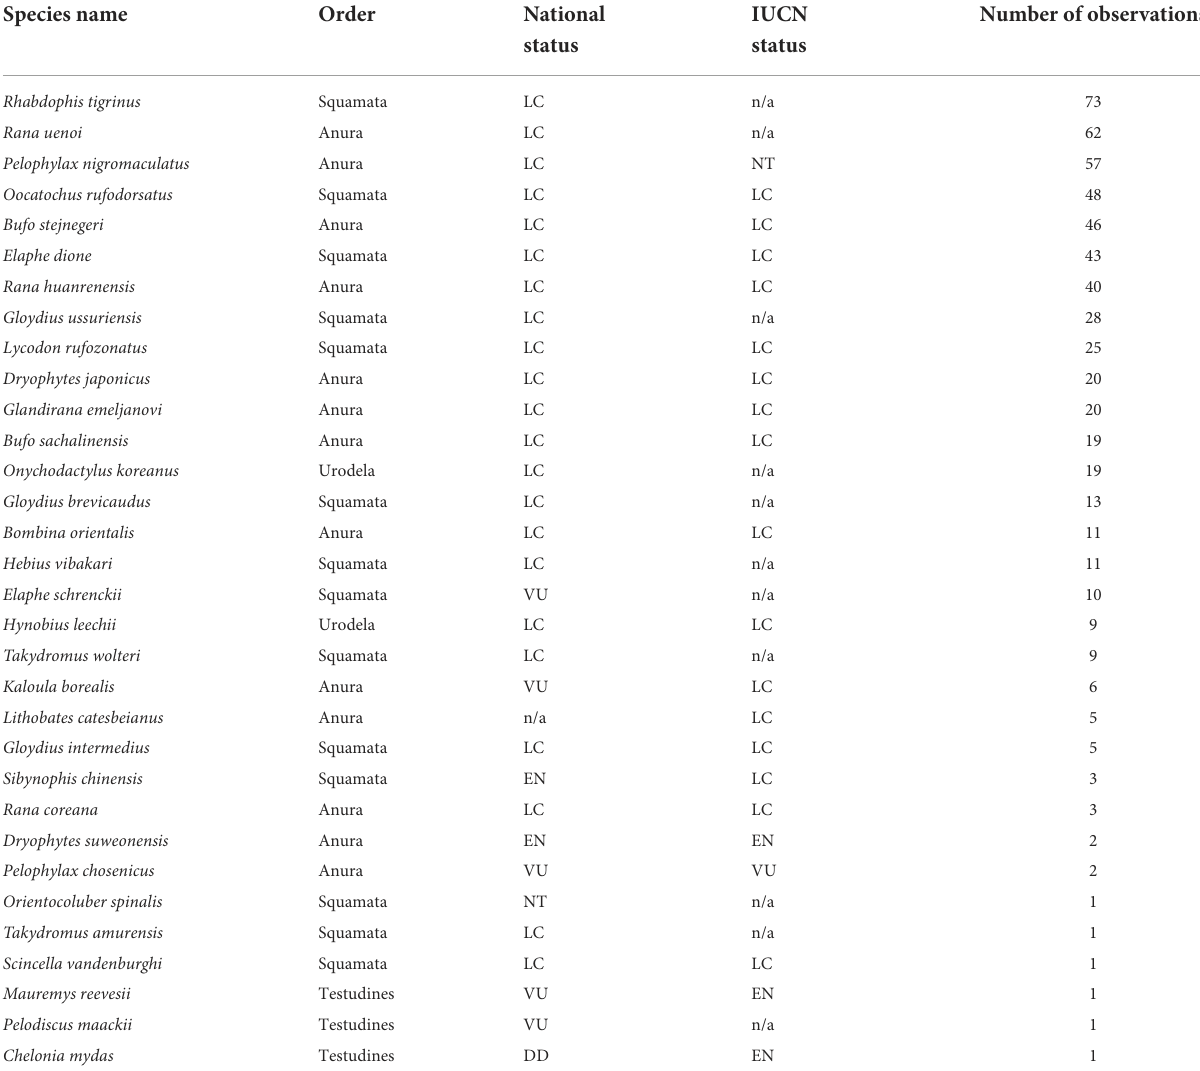
TABLE 2 The list of Korean herpetofauna detected in the raw iNaturalist roadkill dataset ( n = 638) at the point of data analyses, shown alongside Order-level classification, national threat status based on NIBR (2019), and the global threat status based on the IUCN Red List of Threatened Species ( https://www.iucnredlist.org/ ; accessed 4 October 2021), if